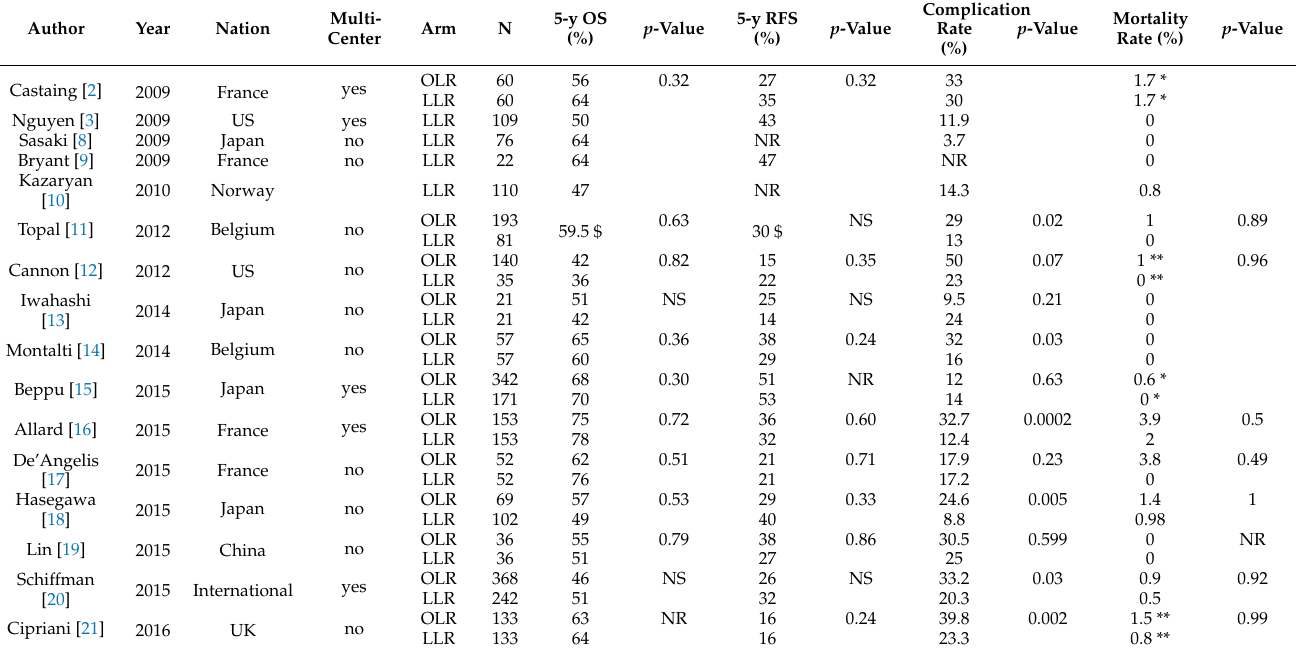
Table 1. Studies evaluating laparoscopic and open liver resections